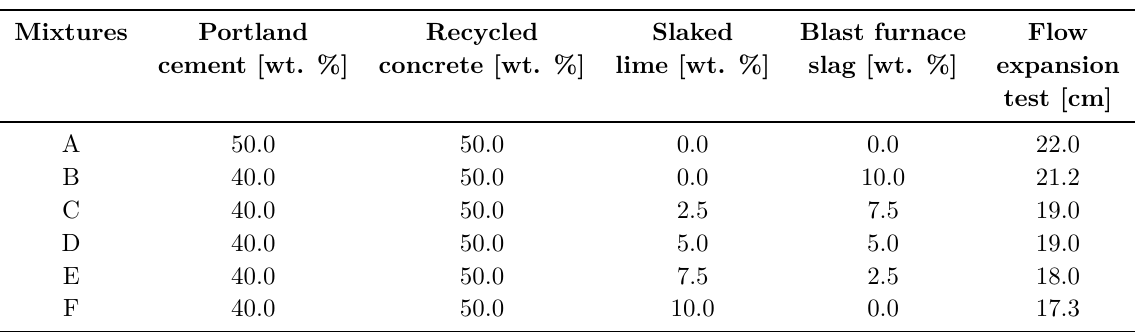
Table 1. Composition of individual samples.